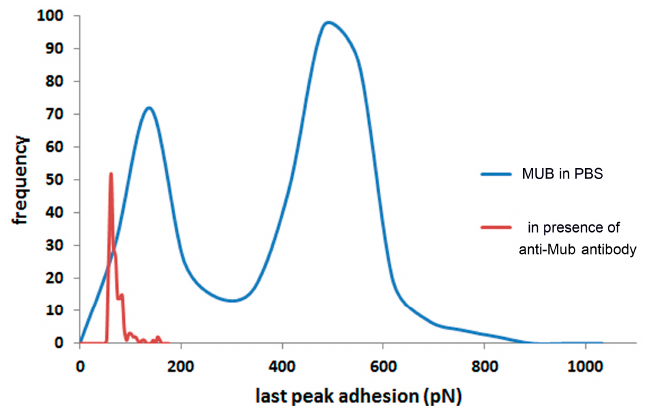
Figure 3. Effect of anti-Mub antibody on the interaction between MUB and pPGM. The histogram data represent the quantification of the MUB–pPGM “rupture” adhesion in the retraction force curves measured between the MUB tip and the mucin coated slide in PBS or in the presence of anti-Mub antibody in the solution.